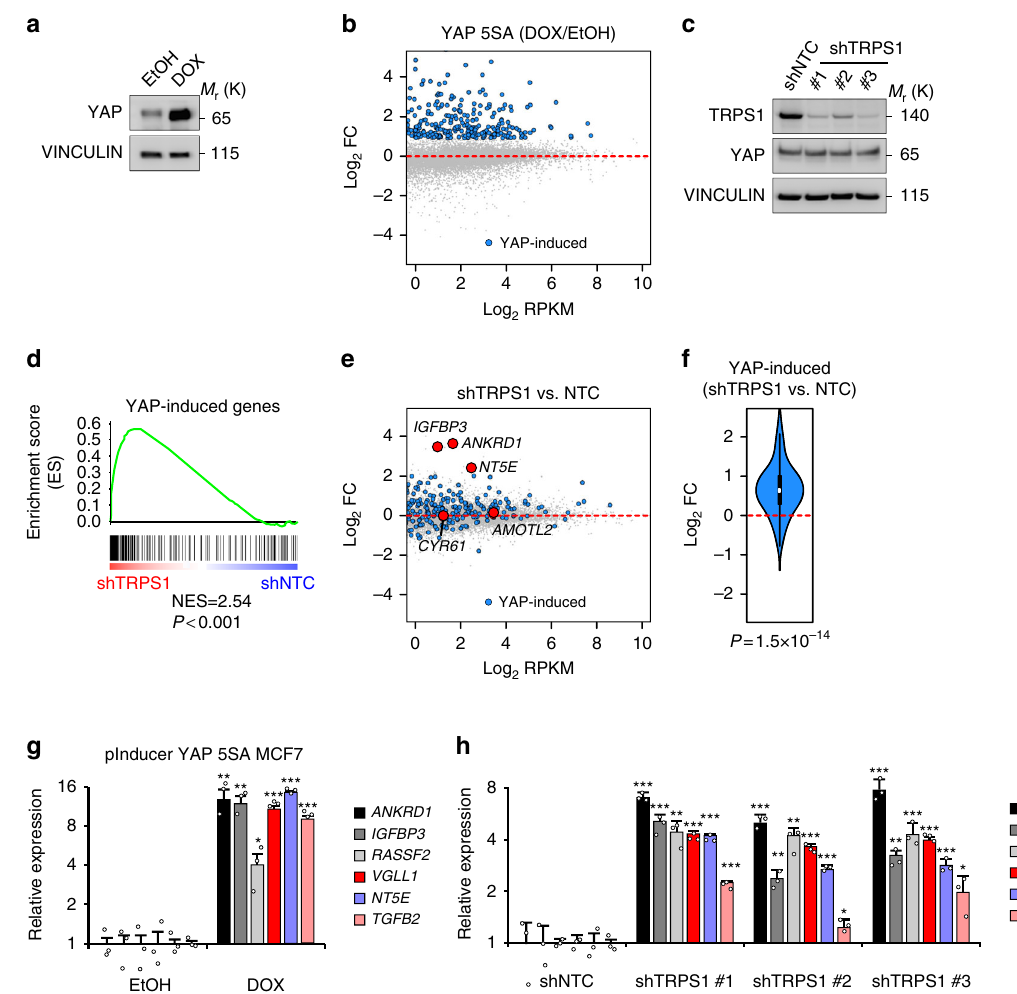
Fig. 2 TRPS1 represses YAP target genes. a Western blot for YAP from MCF7 i5SA (pInducer-Strep YAP 5SA MCF7) cells after 14-h induction by doxycycline (DOX) or ethanol (EtOH), respectively. Vinculin serves as loading control. b MA plot for RNA-Sequencing from MCF7 i5SA cells after doxycycline (DOX) or ethanol (EtOH) treatment for 14 h. The Log 2 fold change (Log 2 FC) is plotted against the abundance of transcripts given as number of reads per kilobase per million mapped reads (RPKM). YAP-induced genes are drawn as blue dots. c Western blot for TRPS1 and YAP after infection of MCF7 cells with three different TRPS1 shRNAs (shTRPS1 #1 – 3) or a non-targeting control (shNTC). Vinculin serves as loading control. d Gene set enrichment analysis (GSEA) for a set of 497 YAP-induced genes in RNA-Sequencing from TRPS1-depleted MCF7 cells. NES normalized enrichment score. e MA plot for RNA-Sequencing from MCF7 cells infected with three different TRPS1 shRNAs or a non-targeting control (shNTC). The Log 2 fold change (Log 2 FC) is plotted against the abundance of transcripts given as number of reads per kilobase per million mapped reads (RPKM). YAP-induced genes are drawn as blue dots. Red dots label established YAP targets. f Violin Plot showing the differential regulation of YAP-induced genes after TRPS1 depletion by shTRPS1.The white point indicates the median. Two-sided Wilcox test. g qRT-PCR analysis of several YAP target genes in MCF7 i5SA cells after induction of YAP 5SA expression by doxycycline (DOX) or ethanol control (EtOH). Data presented are means from three biological replicates ( n = 3) and error bars represent s.e.m; * P < 0.05; ** P < 0.01; *** P < 0.001; Student ’ s t -test. h qRT-PCR analysis of the YAP target genes from g in MCF7 cells infected with three different TRPS1 shRNAs or a non-targeting control (shNTC). Data presented are means from technical triplicates per shRNA and error bars represent s.d.; * P < 0.05; ** P < 0.01; *** P < 0.001; Student ’ s t